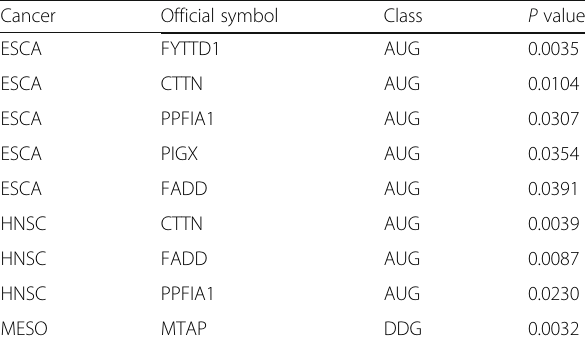
Table 3 Nine highly concordant genes of 5 AUGs and 1 DDG show the strong association with clinical overall survival (OS) in corresponding cancer patients Cancer